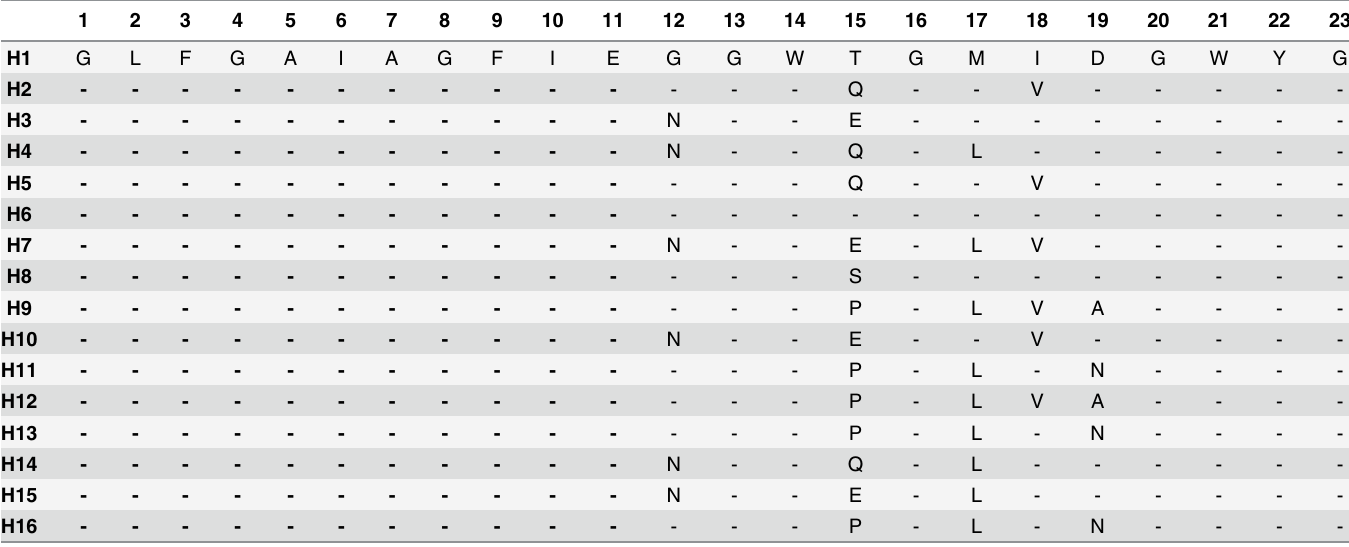
Table 1. Fusion peptide sequences from influenza A virus strains *